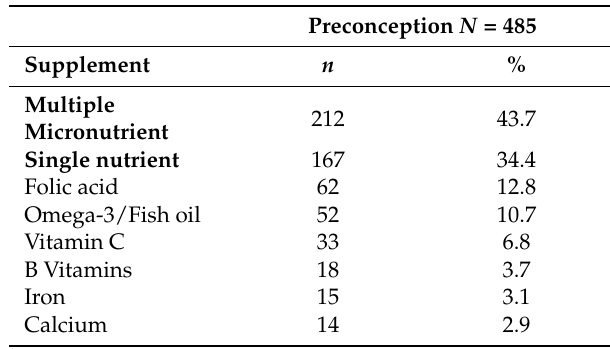
Table 3. Rates of multiple and single micronutrient supplement use among preconception women aged 31–36 years in 2009 from the Australian Longitudinal Study on Women’s Health.